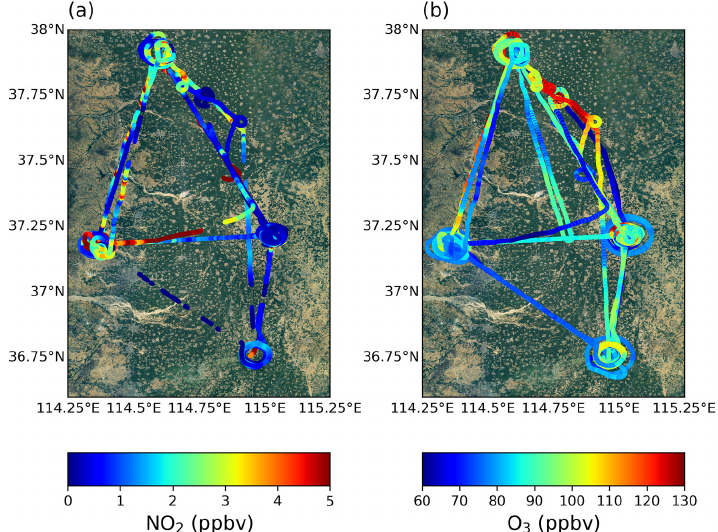
Figure 3. Maps of the ARIAs flight track colored by the 1s measured mixing ratio (ppbv) of NO 2 (a) and O 3 (b) . The background map is provided by Esri ©